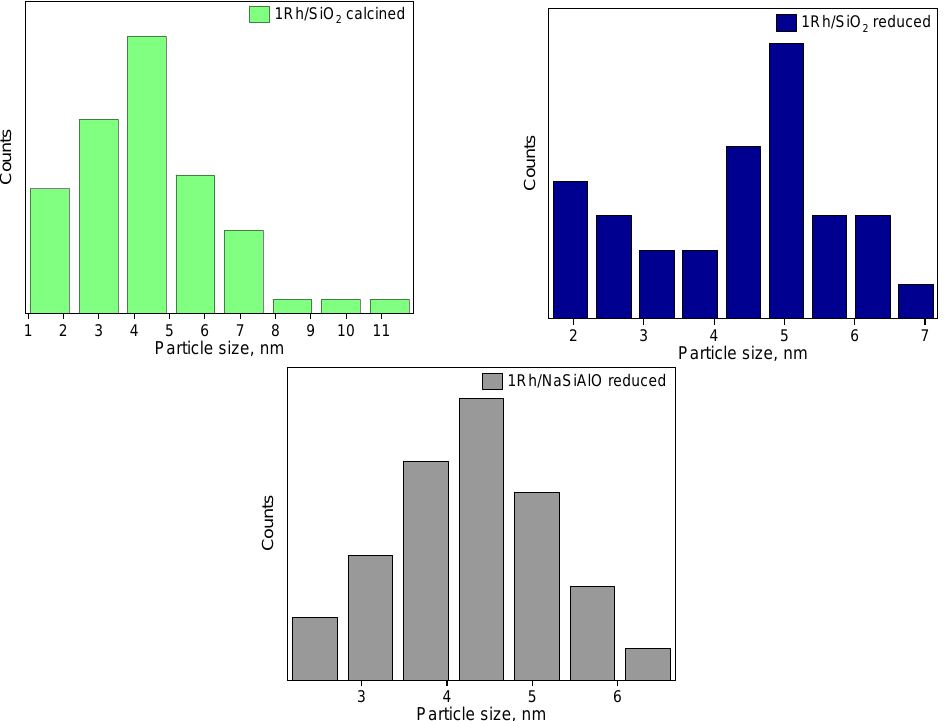
Figure 7. Rh particle distribution by size in the case of initially calcined in air and reduced catalysts.